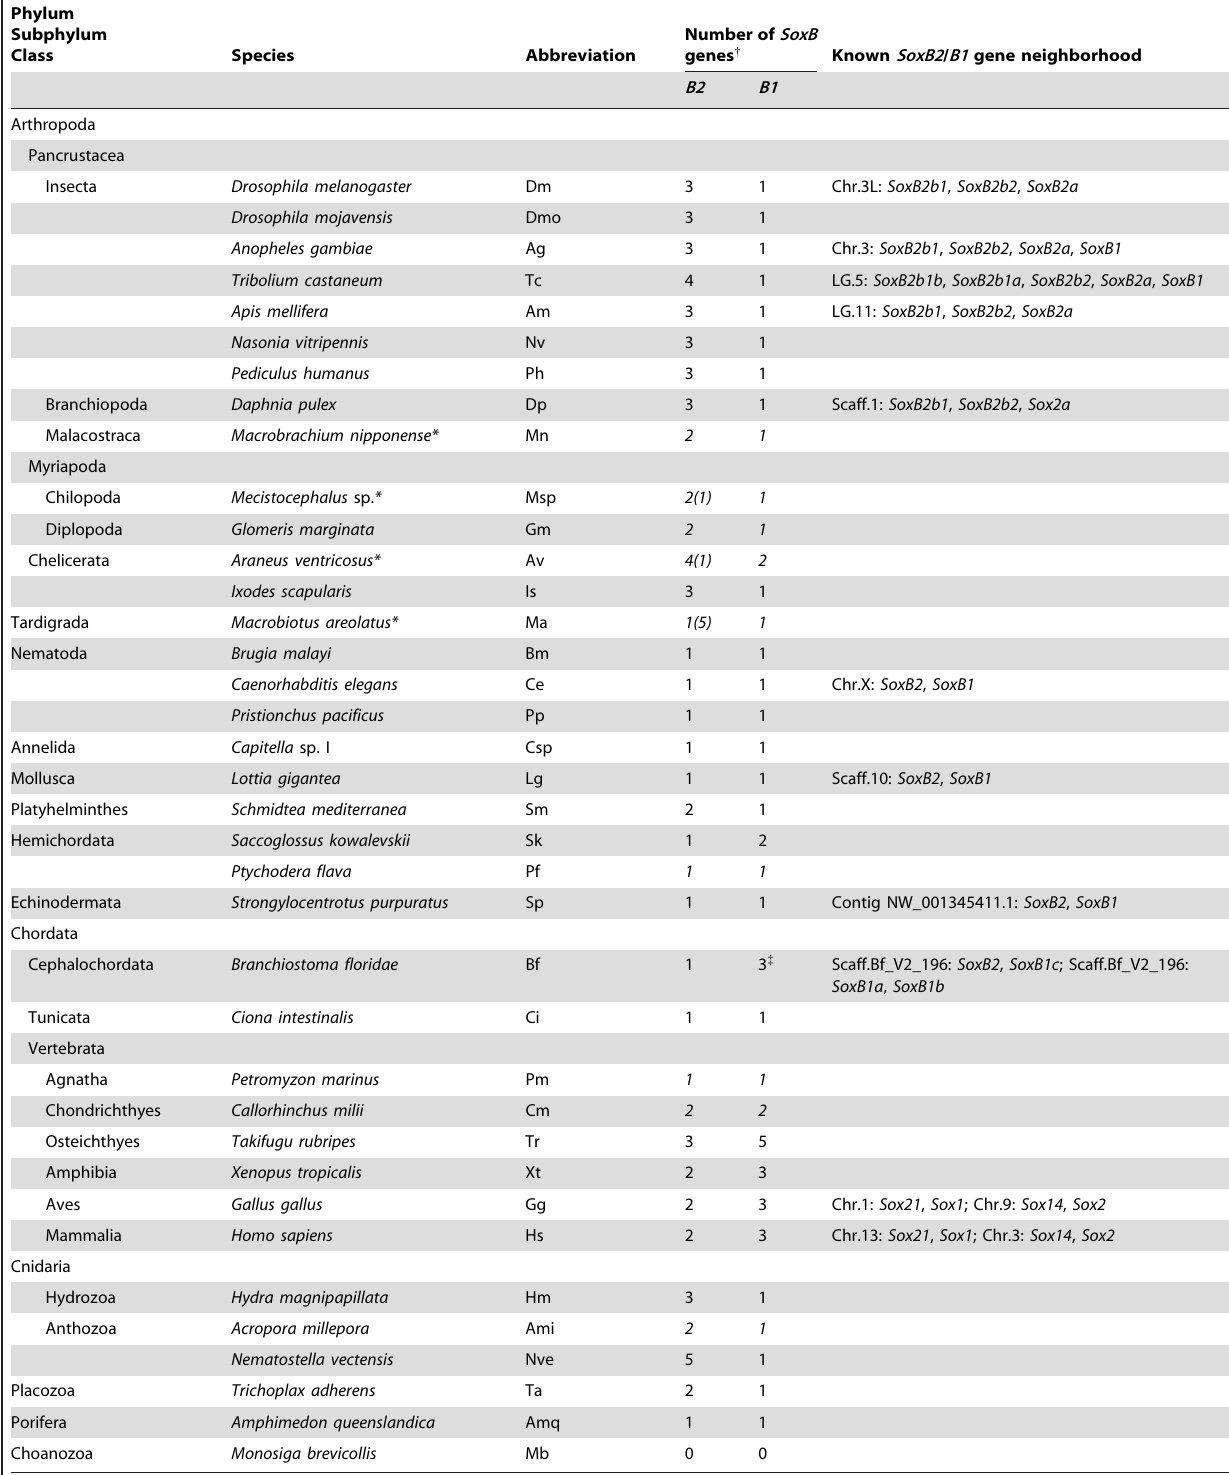
Table 1. Relevant Information for the Species in This